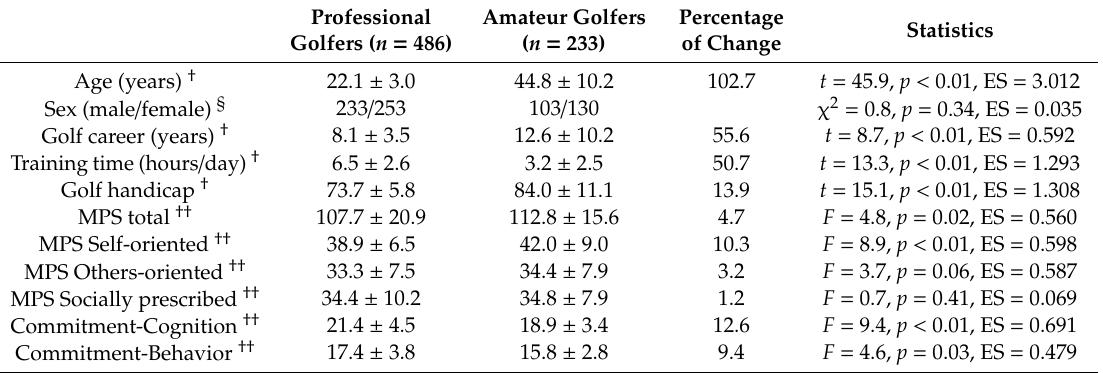
Table 1. Demographic and psychological characteristics of professional golfers vs. amateur